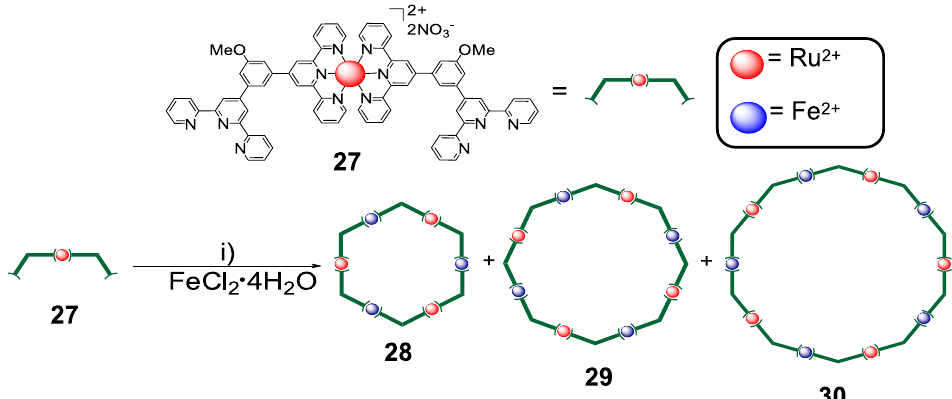
FIGURE 13 – Synthesis of a series of heteronuclear metallocycles using a modified bis terpyridine to minimize the formation smaller materials [Chan, Y.-T.; Li, X.; Moorefield, C. N.; Wesdemiotis, C.; Newkome, G. R. Chem. Eur. J. , v.17, p.7750-7754, 2011 - Reproduced by permission of